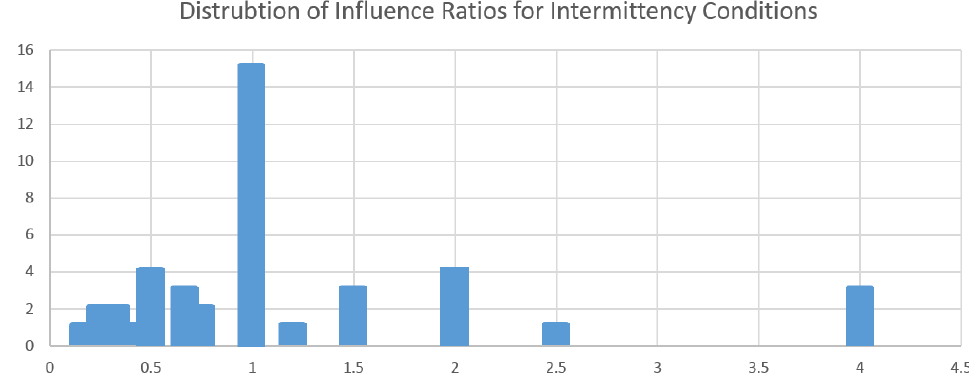
Figure 3. Distribution of Influence Rations of Intermittency Conditions. The most common ratio (15 counts) was unity (1), twelve ratio counts were >1.0, and sixteen were <1.